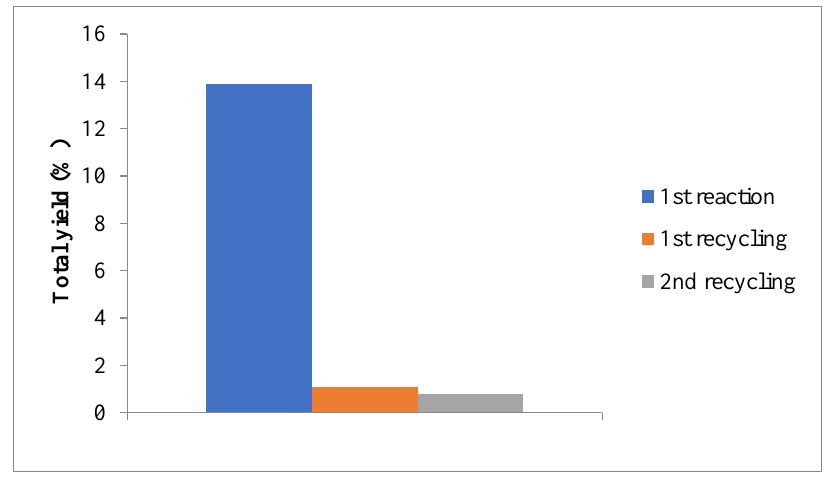
Figure 1. Recycling of the IL + catalyst 1 system.